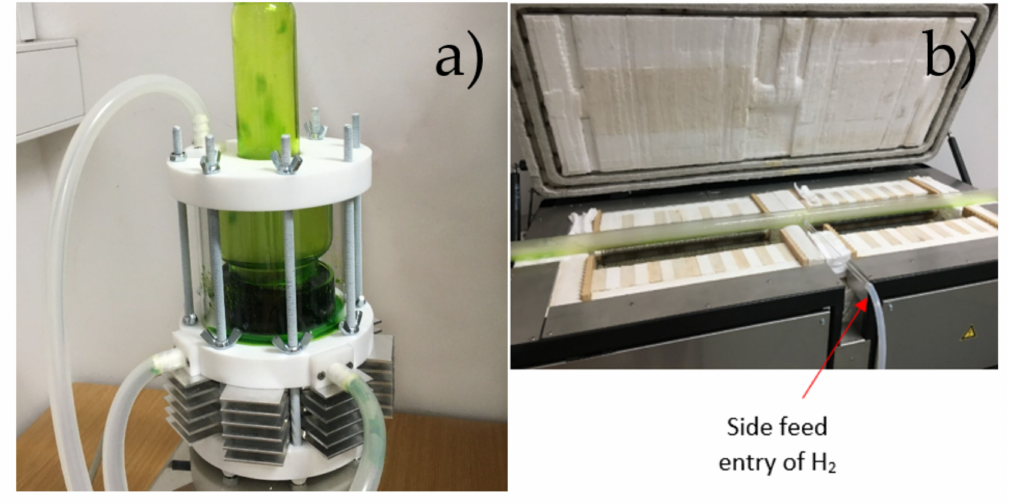
Figure 11. USP device. ( a ) Ultrasonic coloured water generator; ( b ) basic geometry reaction